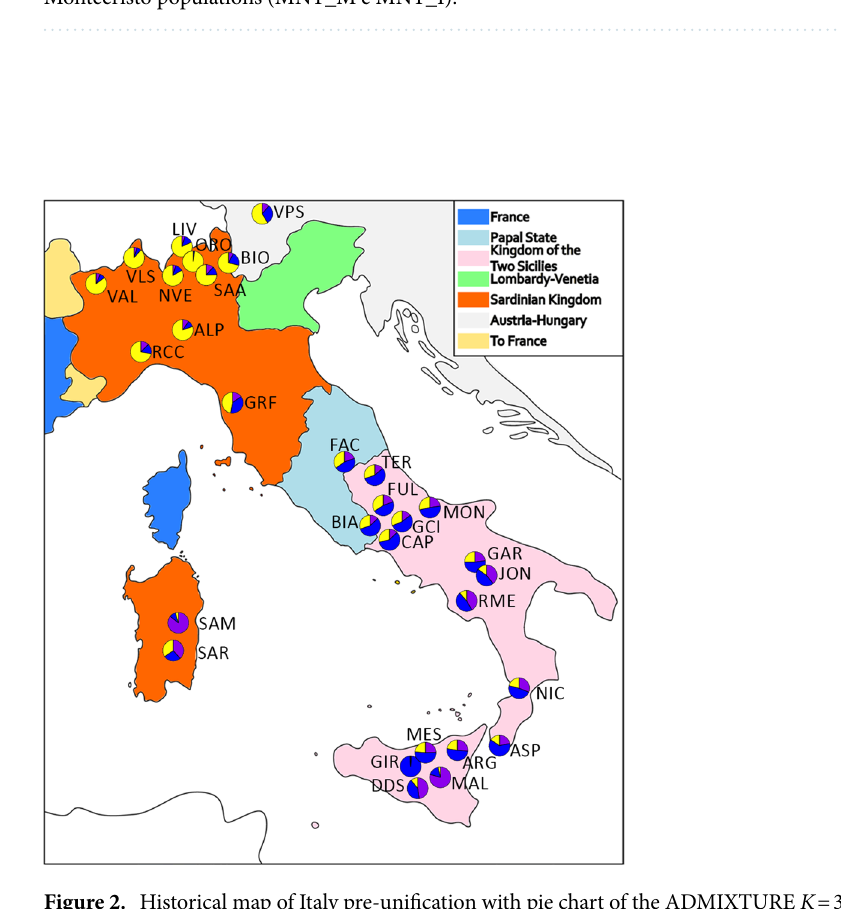
Figure 1. ( a ) MDS plot representing all the populations contained in the dataset, ( b ) MDS plot without the two Montecristo populations (MNT_M e MNT_I).